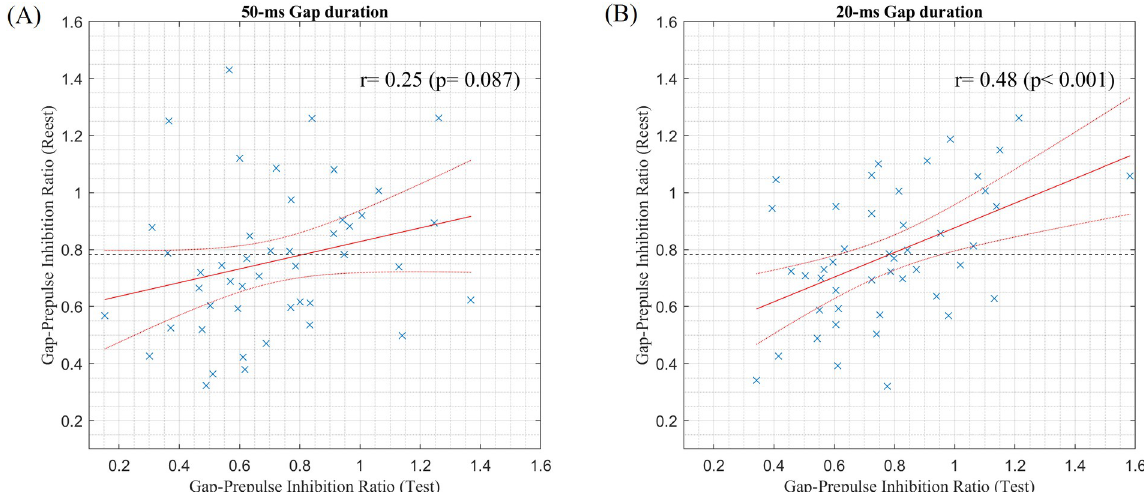
Fig 7. Scatter plots of the Gap/No-Gap ratios between test and retest sessions with 50-(A) and 20-ms (B) gap durations. The red solid and dotted lines indicate the fitting line and 95% confidence intervals, respectively, based on linear regression analysis.